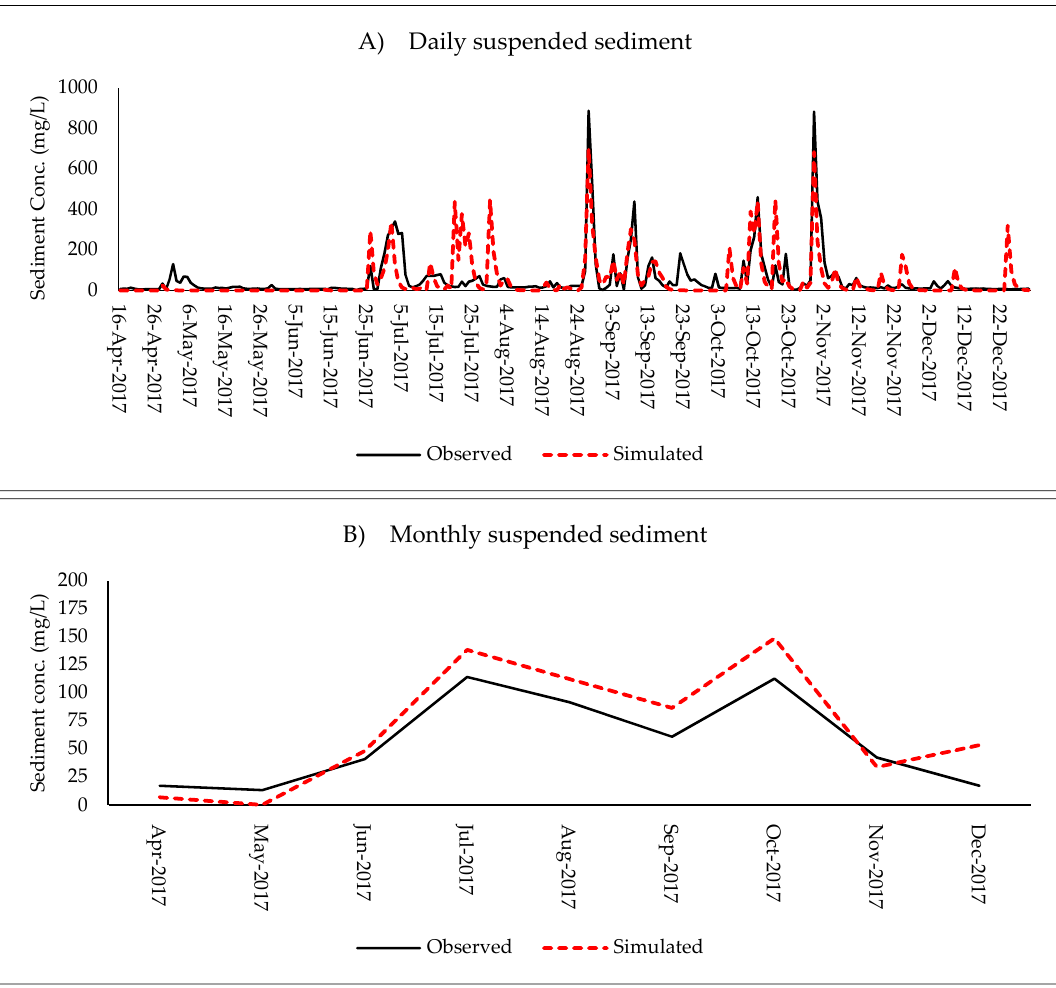
Figure 4. Observed and simulated daily ( A ) and monthly ( B ) suspended sediment in 2GB04 station (Upper Malewa basin).